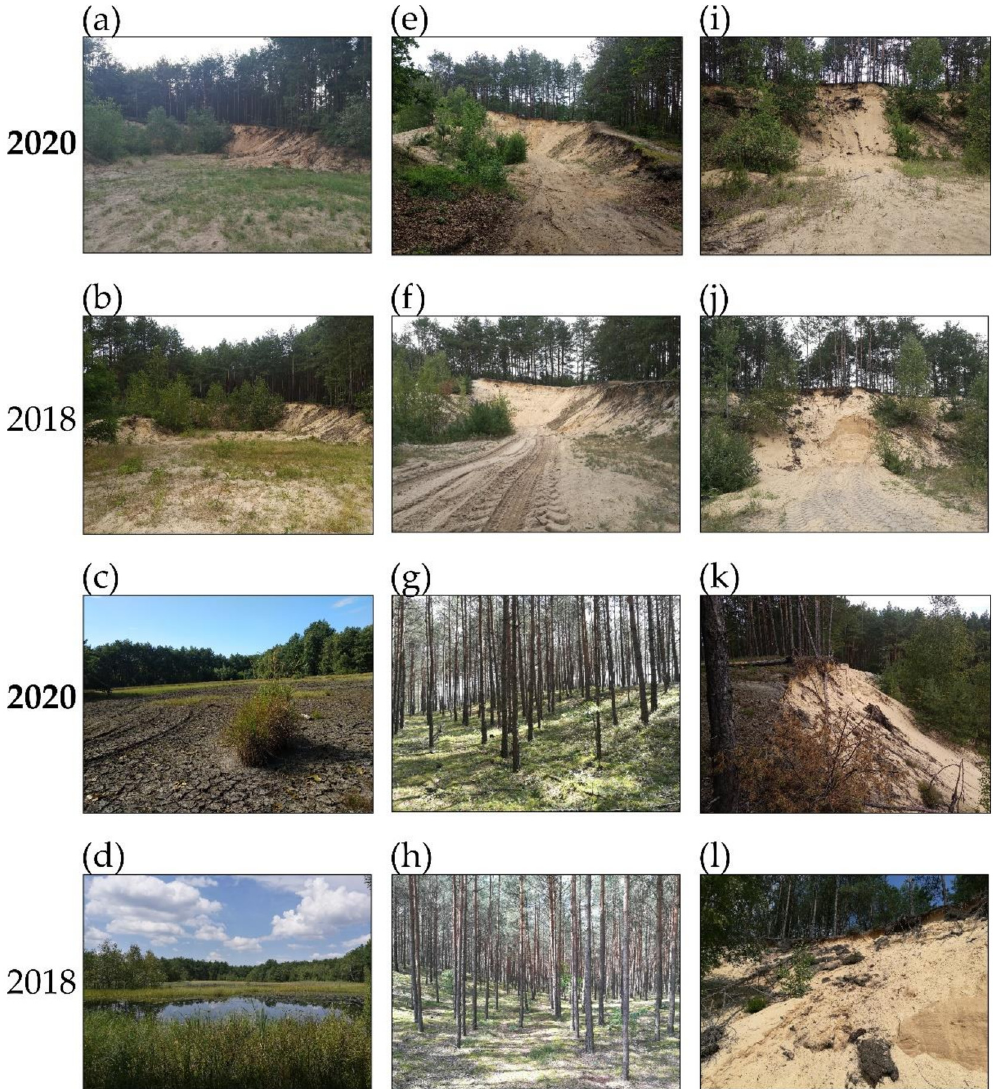
Figure 2. View of the selected portions of the surveyed dune and neighboring terrains in the years of 2020 and 2018: ( a , b ) portion A of the dune—displaying a lack of human activity and the slow encroachment of vegetation; ( e , f ) portion B of the dune—exhibiting low-level human activity in the last year; ( i , j ) portion C of the dune—evidencing low-level human activity in the last year and the progressive succession of vegetation; ( c , d ) blowout temporarily filled with water; ( g , h ) pine monoculture overgrowing the dune; ( k , l ) slope processes on the dune caused by human